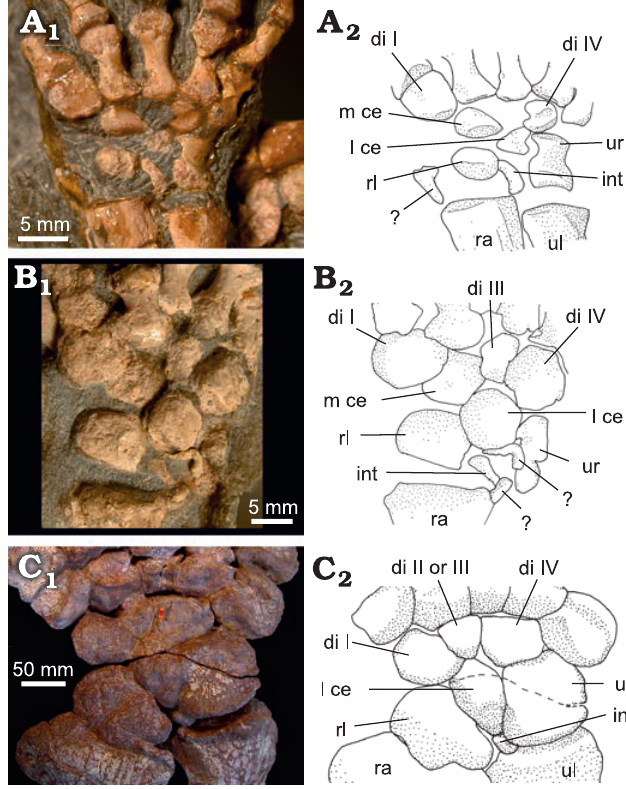
Fig. 5. Carpus of Dicynodontia. A . Diictodon feliceps (Owen 1876), CGS FL186, Jasfontein, Victoria West, South Africa, Tropidostoma Assemblage Zone, Wuchiapingian, right carpus, dorsal view. B . Eosimops